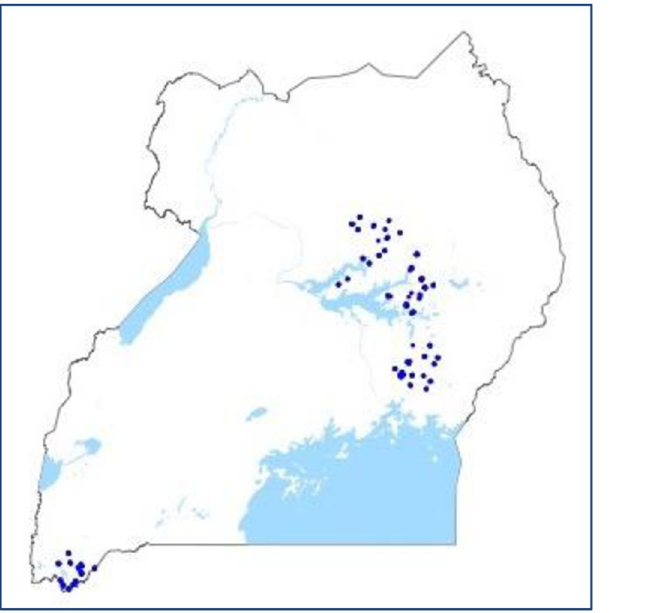
Fig 1. Crop sample